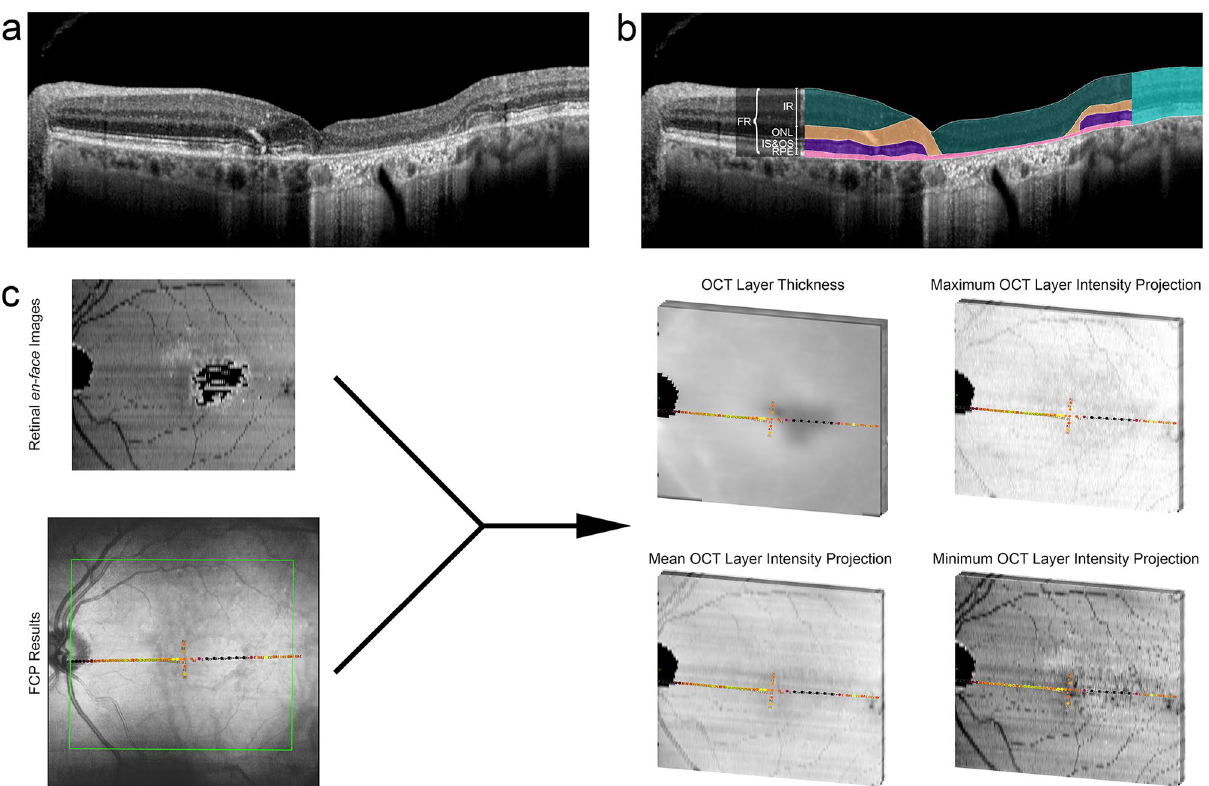
Figure 1. Image segmentation and multimodal registration. ( a , b ) The spectral-domain optical coherence tomography (OCT) volume scan was semi-automatically annotated. The herein used segmentations for the full retina (FR, bright blue overlay), inner retina (IR, green overlay), outer nuclear layer (ONL, yellow overlay), photoreceptor inner and outer segments (IS&OS, purple overlay), retinal pigment epithelium (RPE, pink overlay) are highlighted. ( c ) The fundus-controlled perimetry (FCP) results (color coded dots on infrared reflectance image) were registered to the en-face thickness and projection maps of the five OCT layers. The green rectanlge on the FCP results indicates the location of the respective OCT volume scan. For each stimulus location, the mean thickness as well as mean, maximal and minimal projection intensity were extracted for each